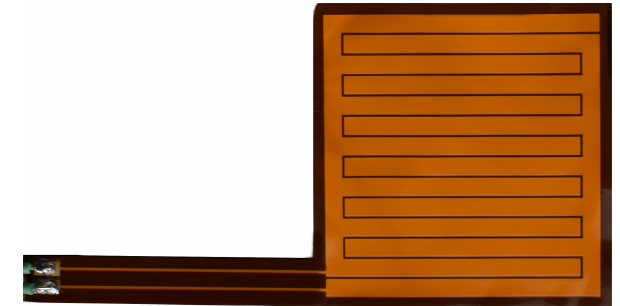
Figure 4. Planar capacitive transducer, manufactured as a flexible printed circuit board, with a thickness of 146µm.